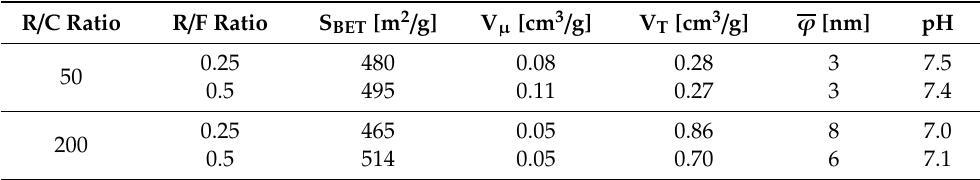
Table A1. Textural properties and initial reaction mixture pH values for RF gels prepared without any